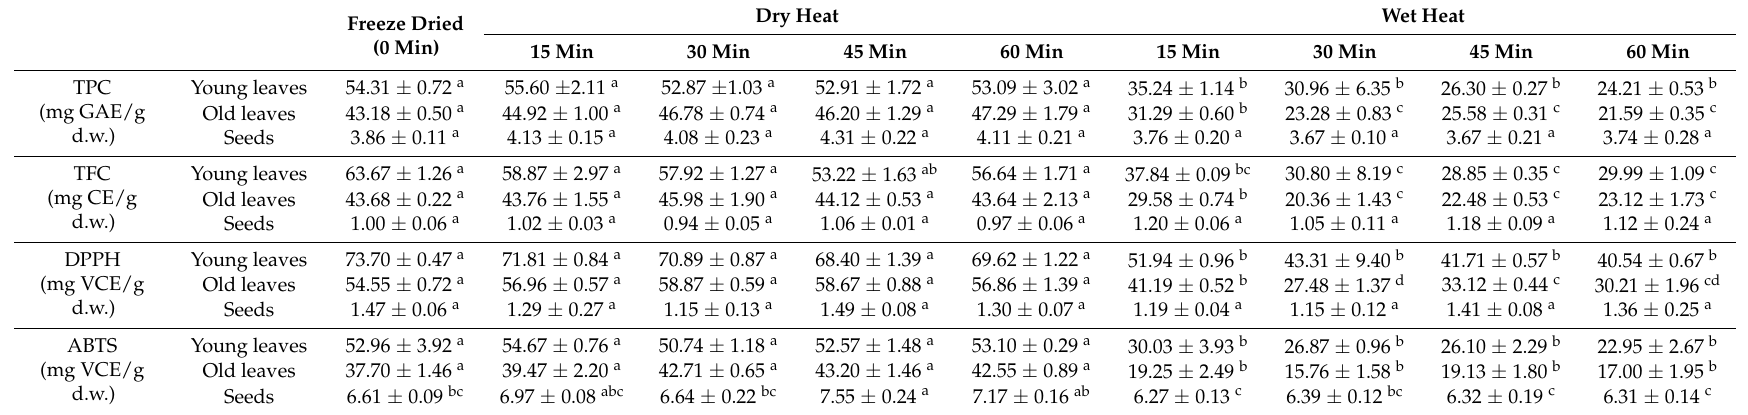
Table 1. Changes in TPC, TFC and antioxidant activities (DPPH and ABTS radical scavenging ability) after thermal treatment of young and old faba leaves and faba